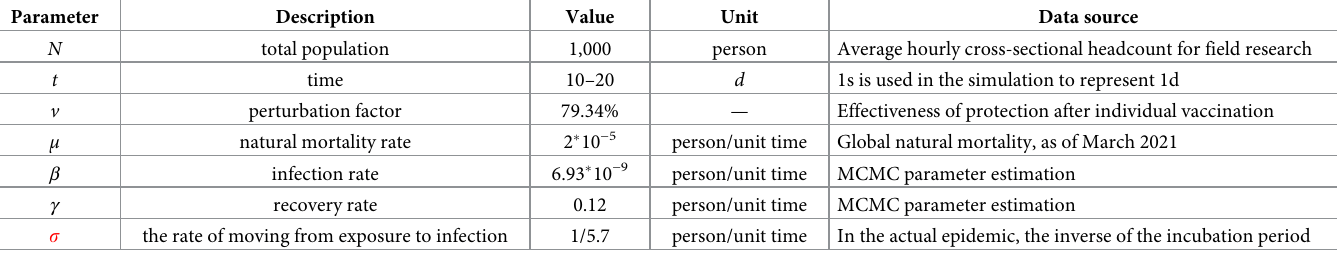
Table 3. Parameter values after experimental